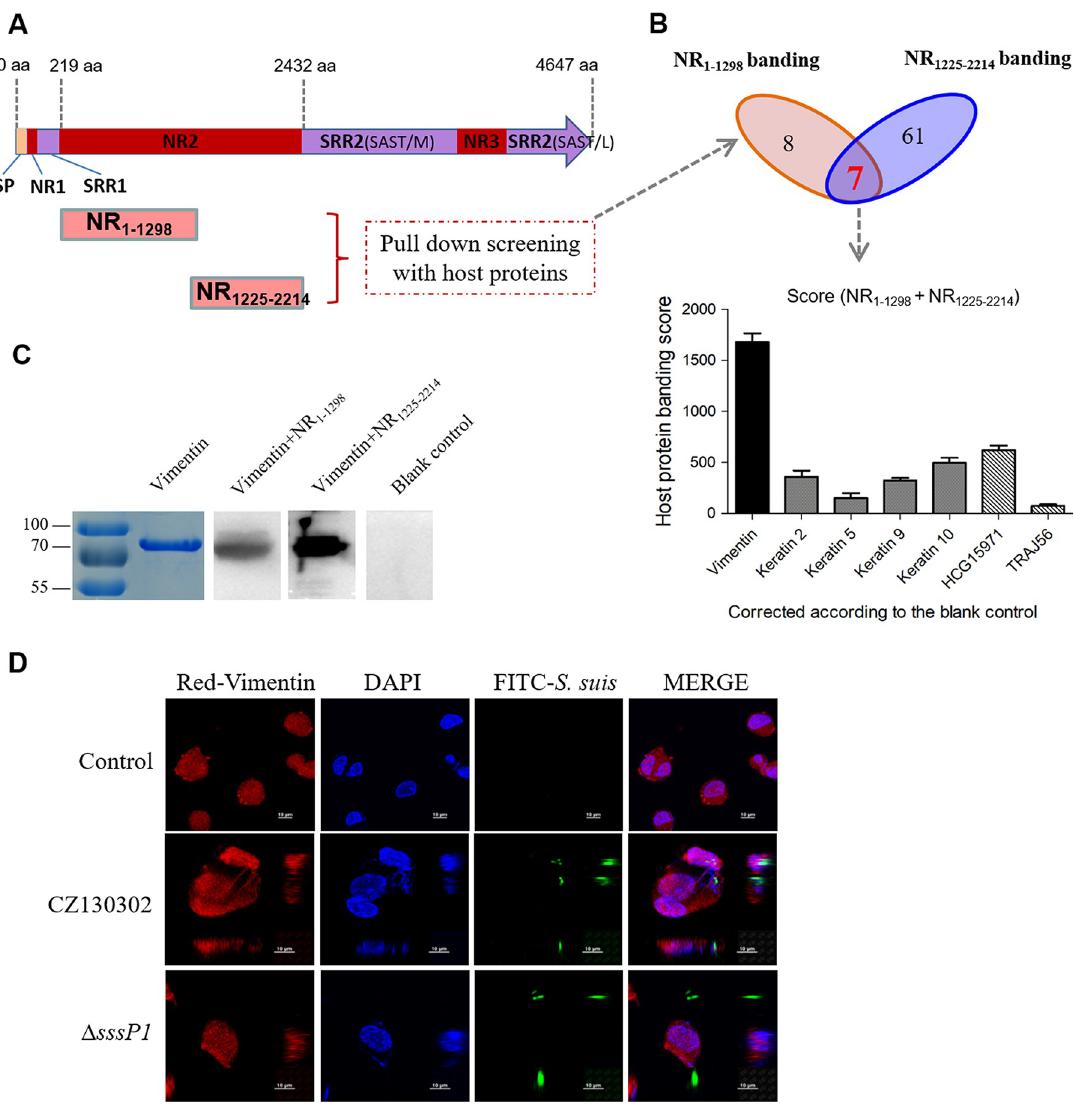
Fig 5. Vimentin of HBMECs was screened as a vital receptor of SssP1. (A) Schematic diagram of the domain architecture of SssP1 and the location of NR 1-1298 and NR 1225-2214 . (B) The analysis of the screened host proteins by pull-down assays of SssP1-NR 1-1298 and SssP1-NR 1225-2214 is based on the data shown in Tables 1 and S2. The binding score represents the ability to interact with SssP1 based on the protein loads measured in the pull-down assays. (C) The Far-Western blot was performed to identify the interaction between vimentin and the indicated NR fragments of SssP1. (D) Visual observation of the localisation of vimentin and S . suis co-incubated with the HBMECs. The vimentin skeleton was stained by indirect immunofluorescence (IIF) in red, the nuclei were counterstained with DAPI in blue, and the S . suis cells with green fluorescent plasmid pKSM410-rss29 were observed in green.